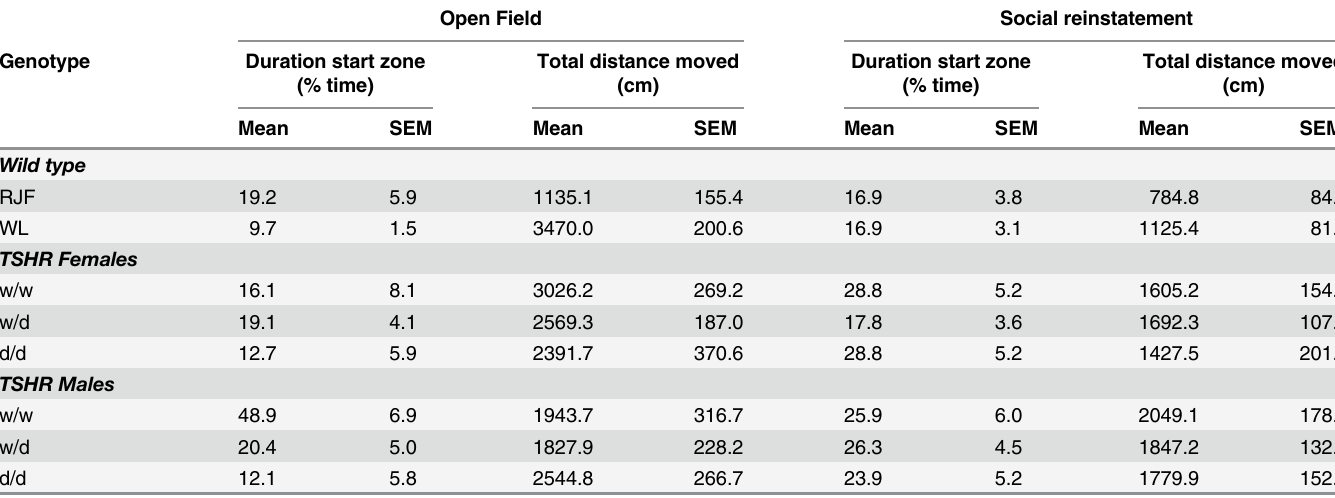
Table 2. Means ( ± SEM) of the variables measured in the open field (OF) and social reinstatement (SR) test.